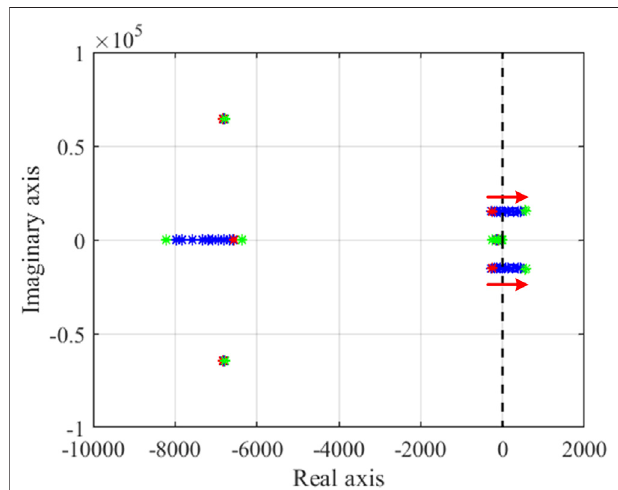
FIGURE 7 | Root locus with the change of k pv (PQ node).